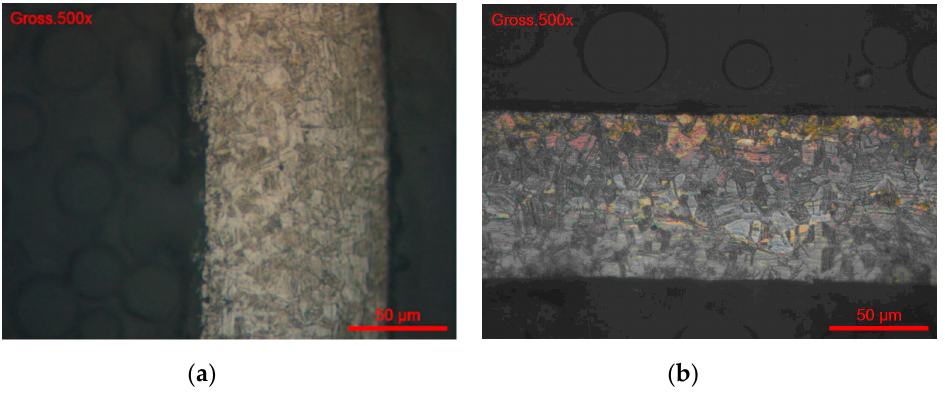
Figure 18. ( a )#Test 1 and ( b ) #Test 2. Grain index (ASTM E112-13) G = 11.